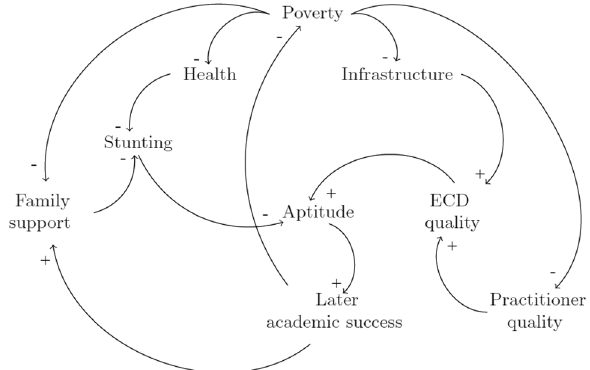
Fig. 1 Causal loop diagram for early childhood